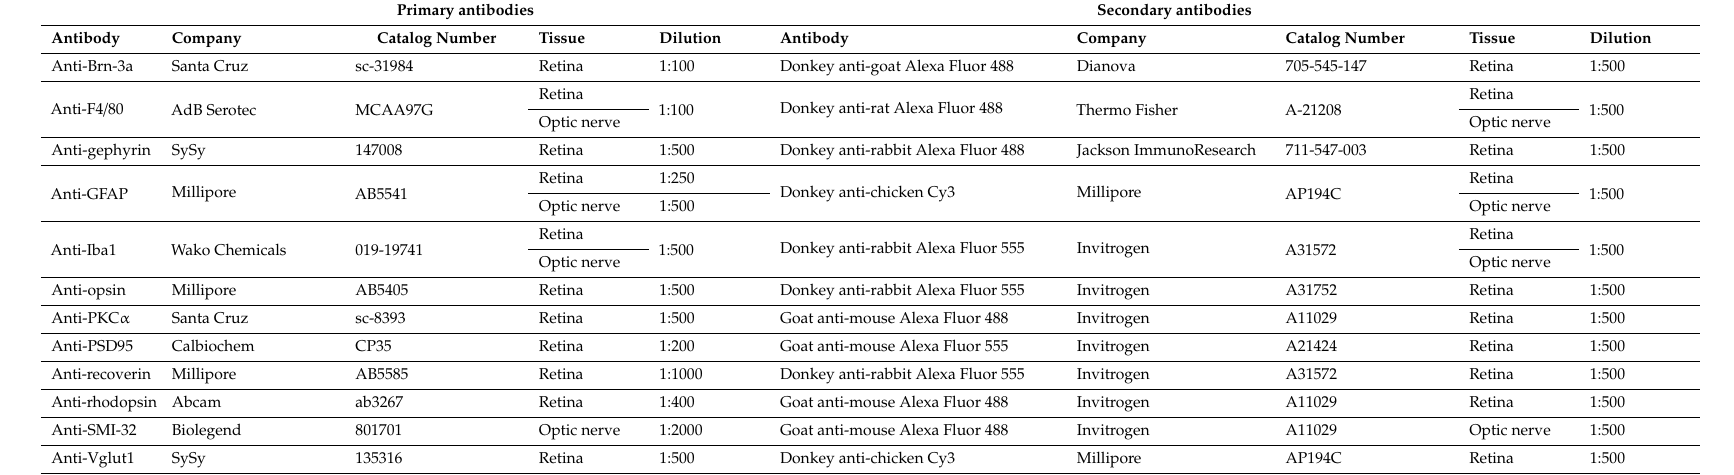
Table 1. Primary and secondary antibodies used for